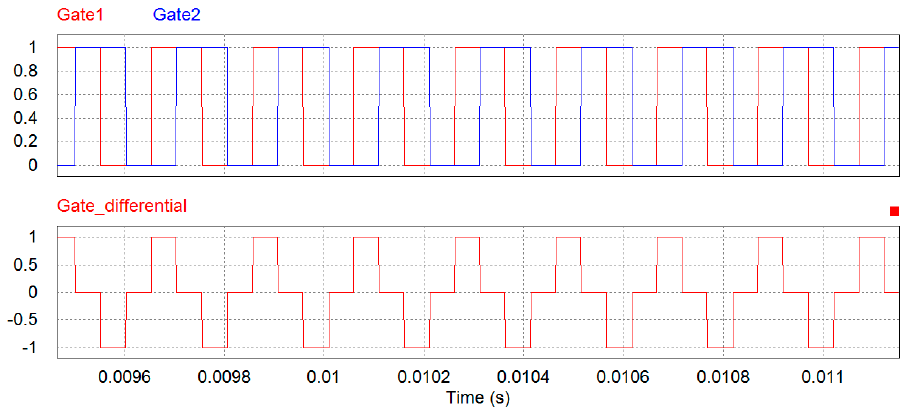
Figure 12. 1/4 T s of the phase error. Two gate signals (upper) and error (lower).